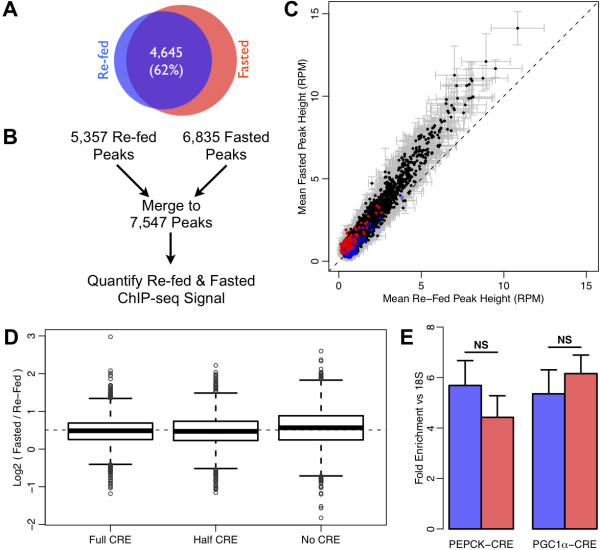
Differential CREB binding analysis. A) Venn diagram of high-confidence CREB site calls in the re-fed (blue) and fasted (red) mouse liver suggests thousands of condition-specific binding events. B) Flowchart of quantitative analysis. C) Scatter-plot of average peak height (RPM = reads per million) across all fasted and re-fed replicates, for 7,547 merged peaks. Black dots correspond to peaks called in both conditions, red dots correspond to peaks called only in the fasted group, and blue dots correspond to peaks called only in the re-fed group. Gray error bars indicate SEM. D) Boxplot of log2 fasted/re-fed ratio of peak height for subsets of CREB binding sites based on occurrence of canonical full or half CRE sequence within 50 bp of peak center. E) ChIP-qPCR of CREB binding in the re-fed (blue) and fasted (red) groups on known fasting-induced CREB target genes. Neither change is significant at p-value of 0.05 threshold (one-tailed Student’s t-test).